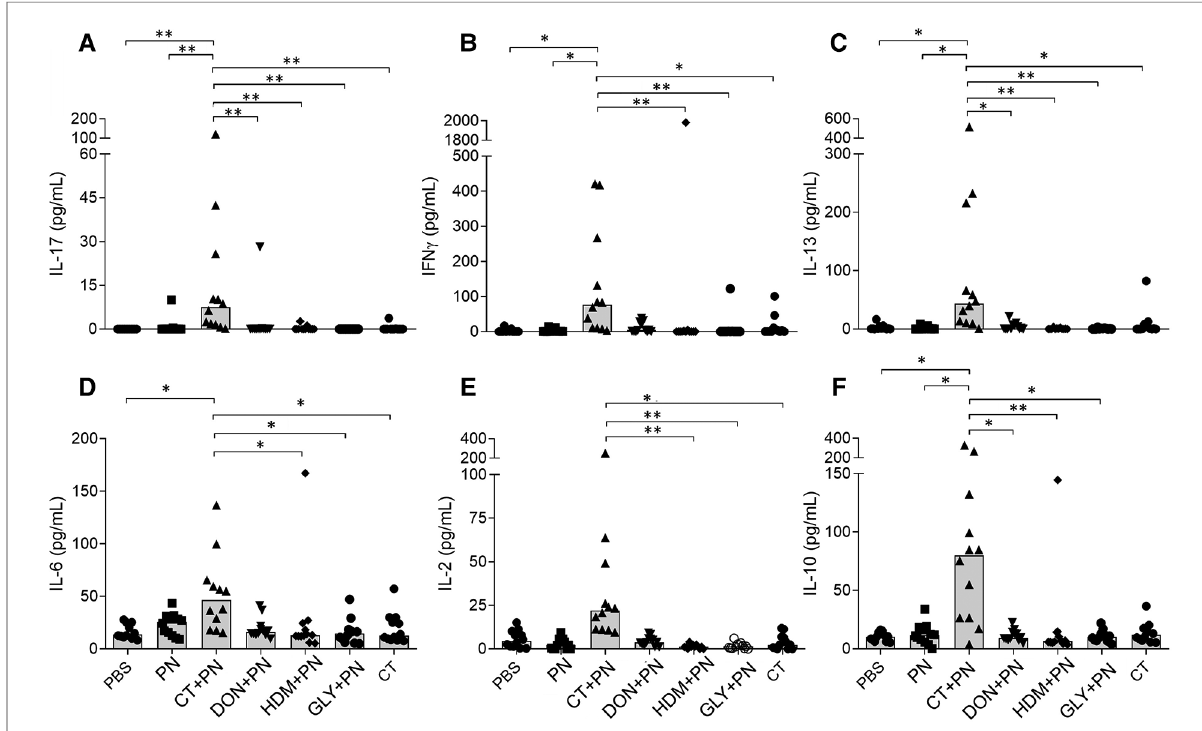
FIGURE 3 Cytokine release from PN-stimulated spleen cells ex vivo; (A) IL-17, (B) INF γ , (C) IL-13, (D) IL-6, (E) IL-2 and (F) IL-10. Mice were repeatedly immunized and received a PN challenge ( n =12), followed by spleen cell harvesting. Brackets denote statistically signi fi cant differences (* p <0.05, ** p <0.001) between two groups. Columns denote the group median value while each symbol denote individual